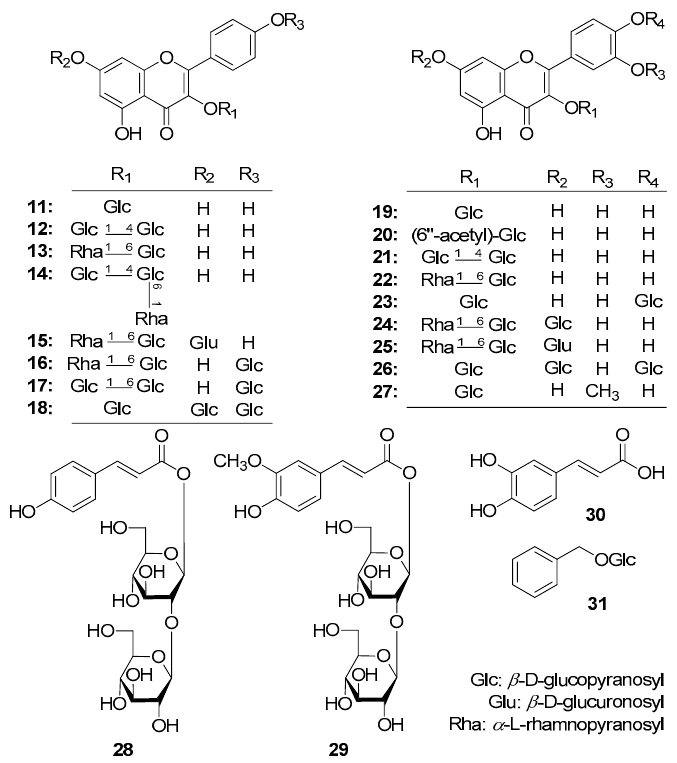
Figure 2. The known compounds obtained from the aerial parts of A. mongolicum ( 11 − 31 ).